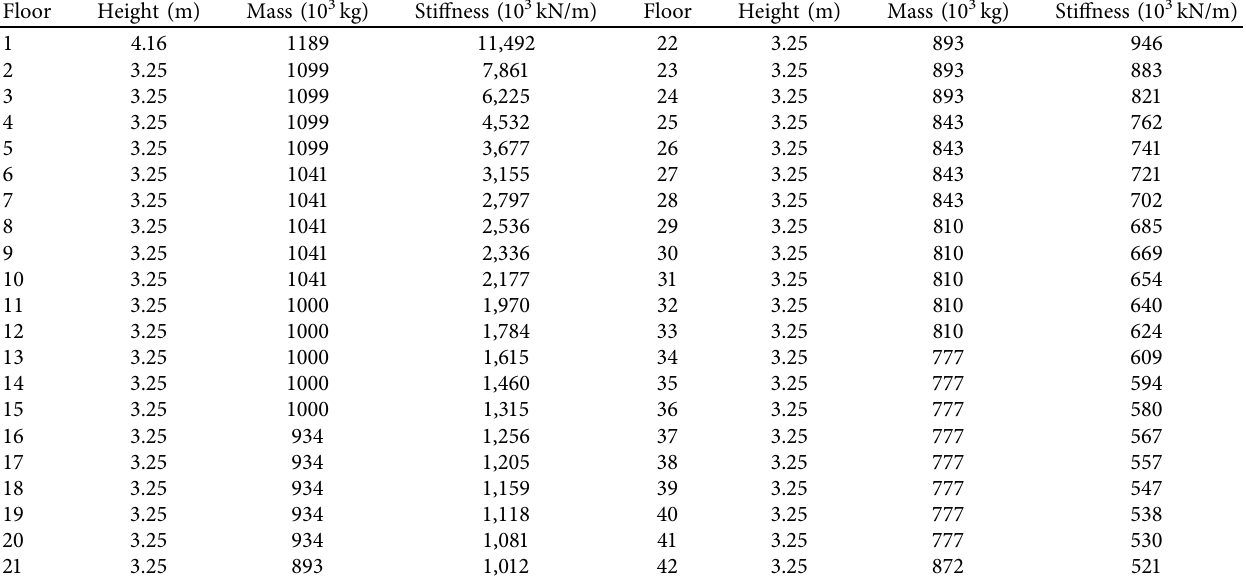
Table 9: Dynamic properties of 42-story